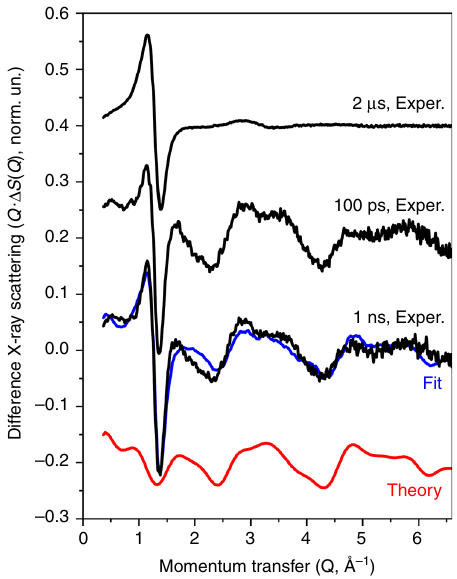
Fig. 4 Pump-probe X-ray scattering for [Cu 4 ( PCP ) 3 ] + . Experimental pump-probe X-ray scattering signals corresponding to a 2 µ s, 100 ps, and 1 ns delay from photoexcitation (black lines). Theoretical X-ray scattering difference for the DFT-based models calculated taking into account structural changes of [Cu 4 ( PCP ) 3 ] + as a result of the transition to the triplet state (red line). Fit that takes into account additionally the bulk solvent response due to ultrafast heating (blue line). The signal corresponding to 2 µ s delay has been divided by 6.5 to match the